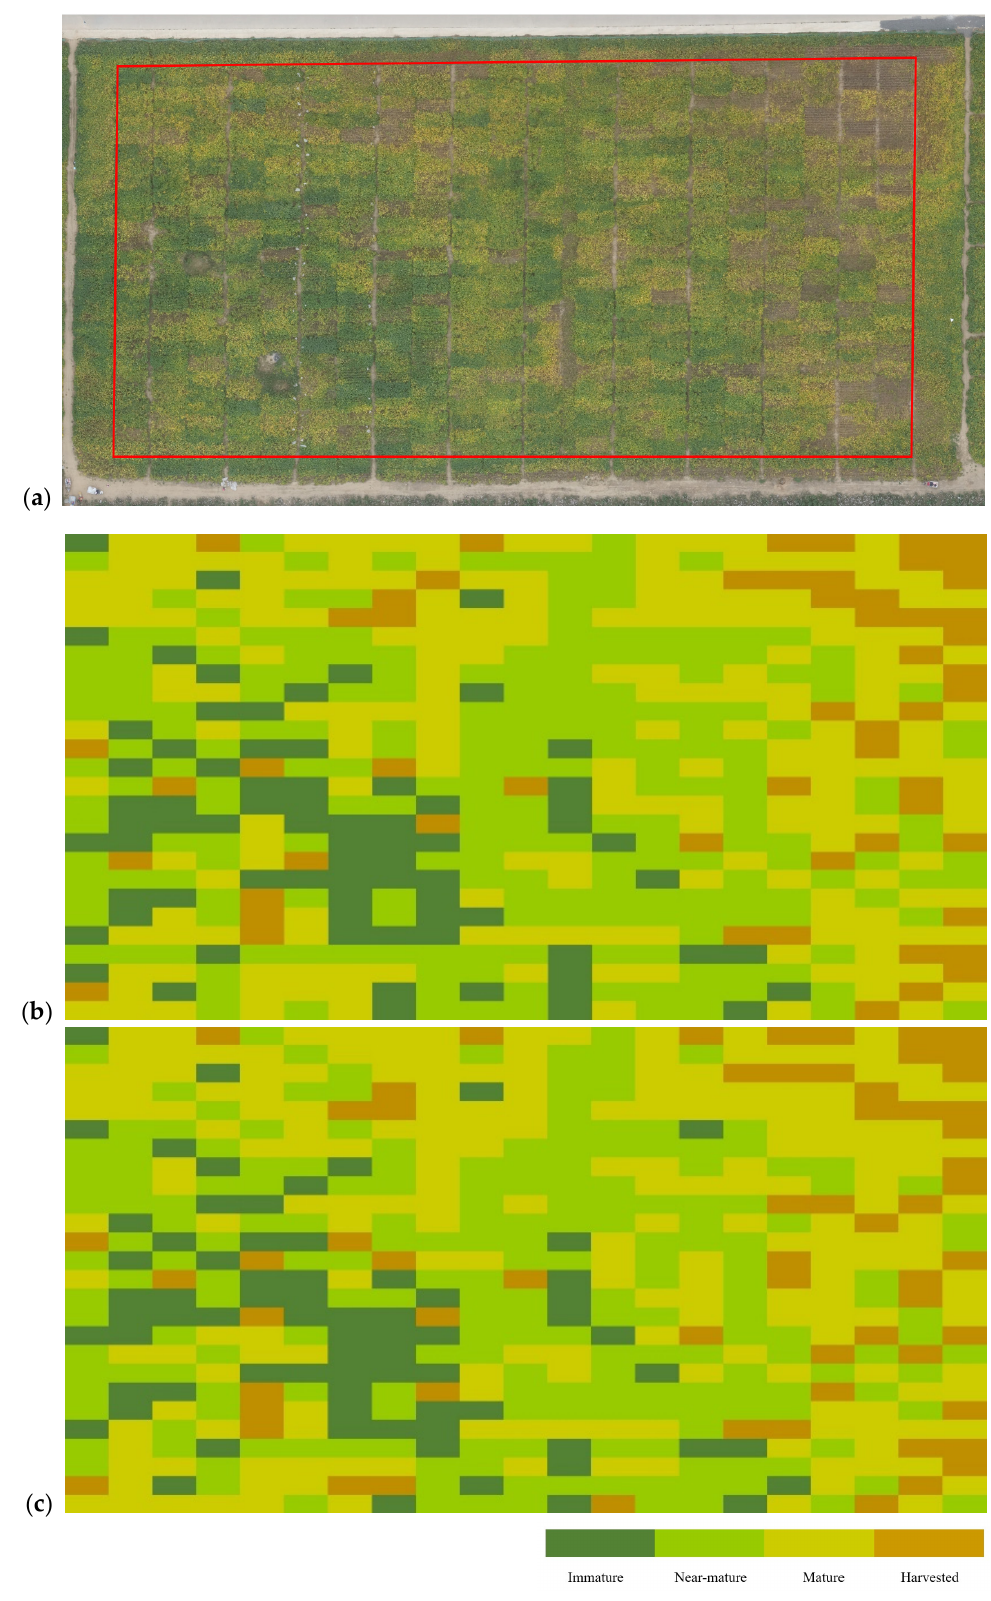
Figure 7. Maturity maps. ( a ) RGB true-color image; ( b ) DS-SoybeanNet (5 × 5); and ( c ) DS-SoybeanNet (7 × 7). Note: The red rectangle indicates the soybean plot region.